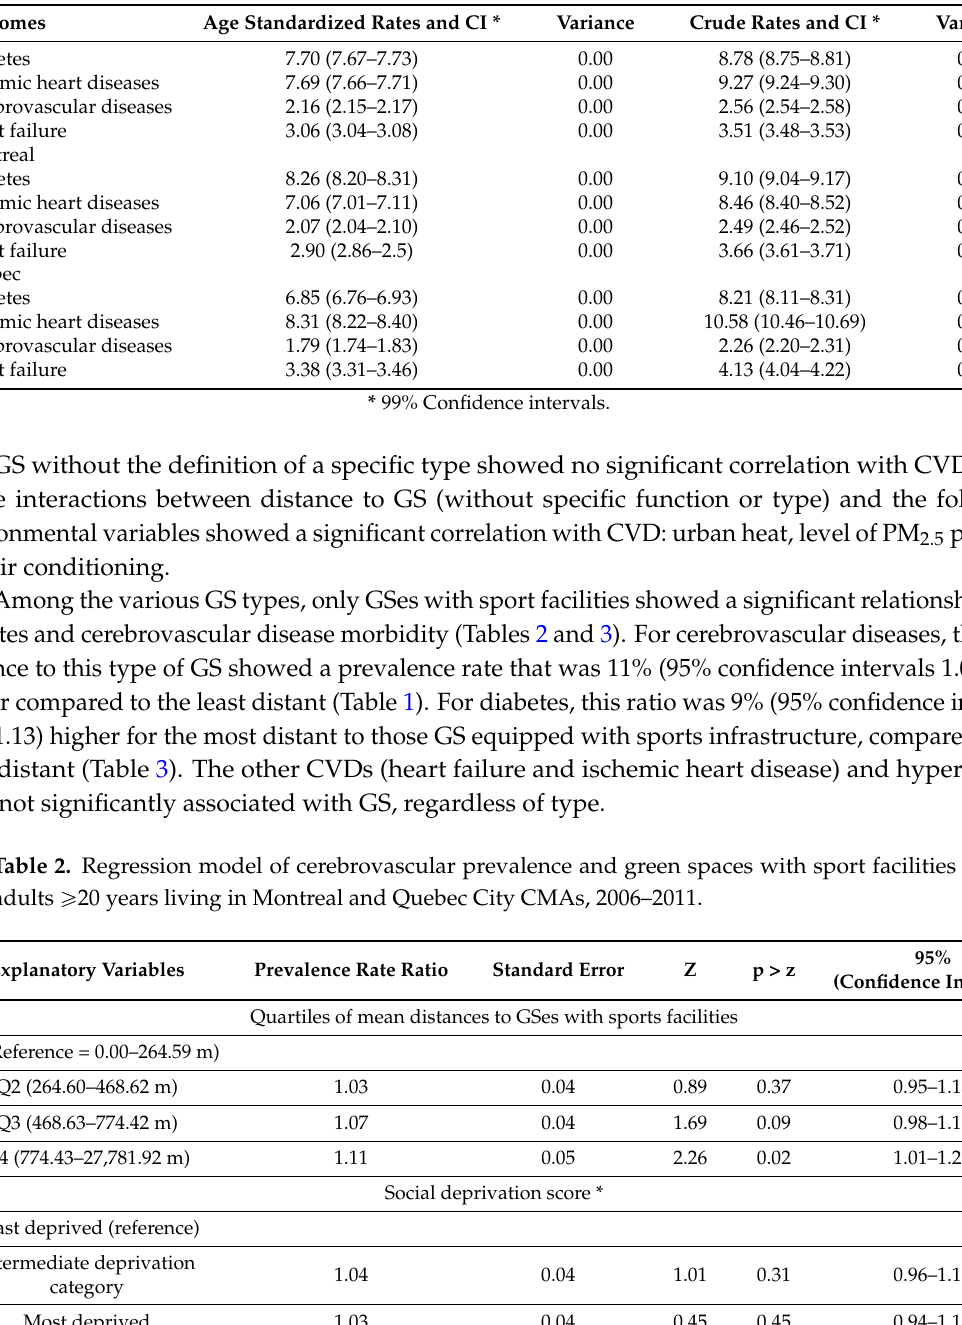
Table 1. Age standardized and crude rate statistics of the outcomes.